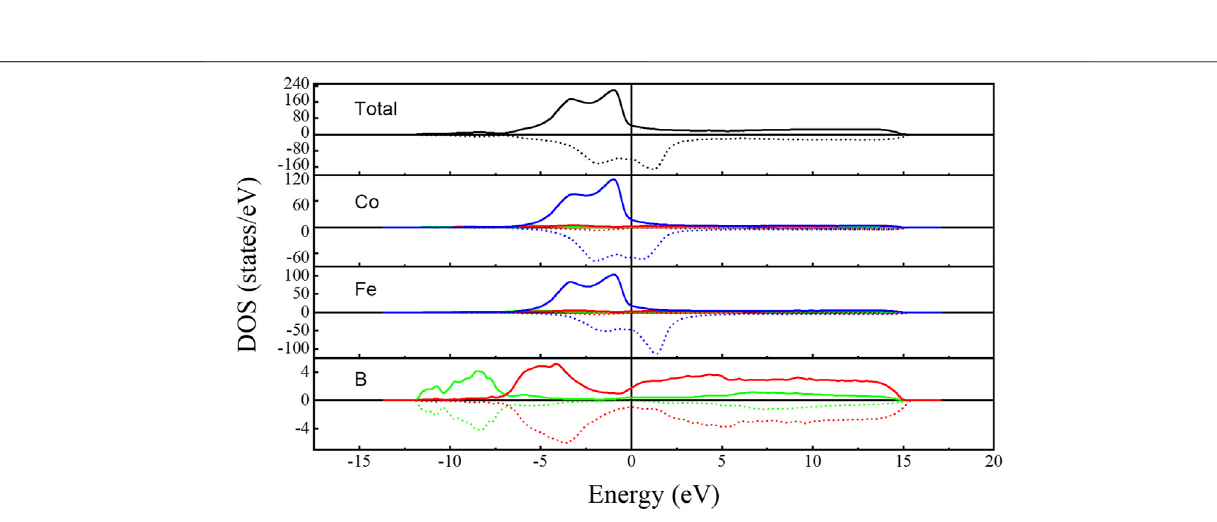
Frontiers in Materials |